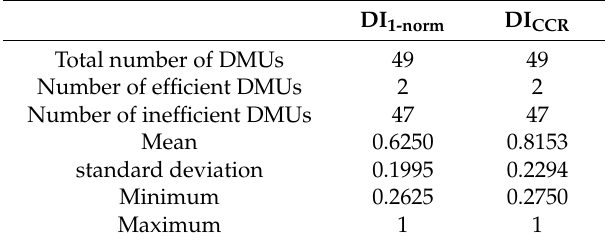
Table 3. Descriptive statistics for data envelopment analysis (DEA) and 1-norm results.